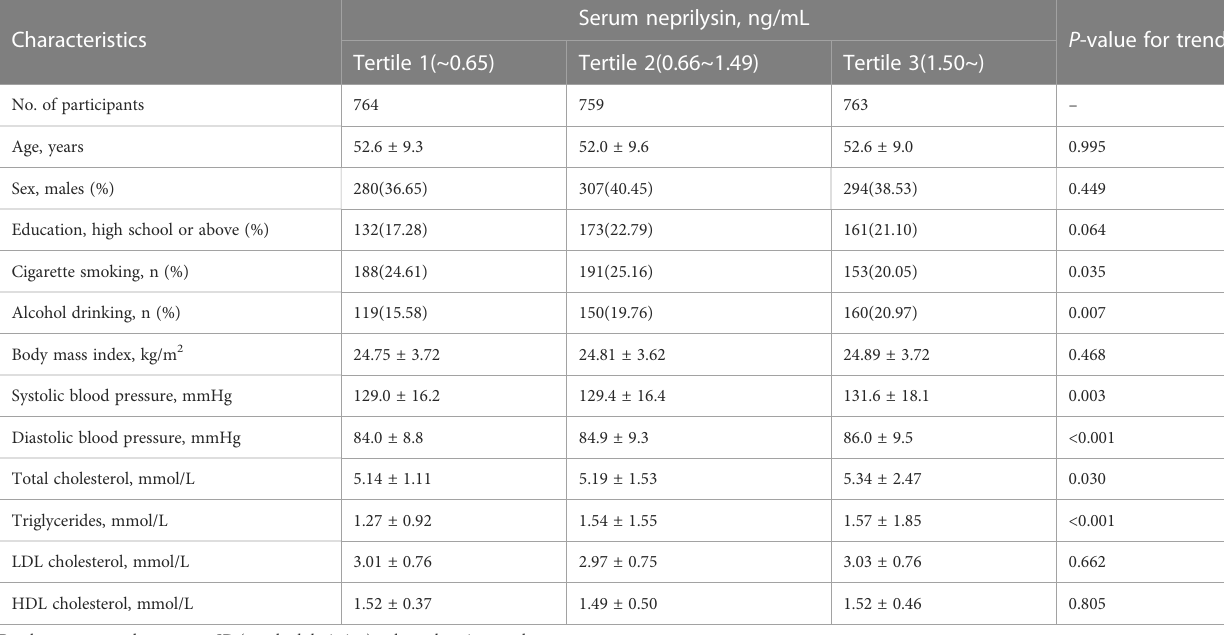
TABLE 1 Baseline characteristics of study participants according to serum neprilysin levels.